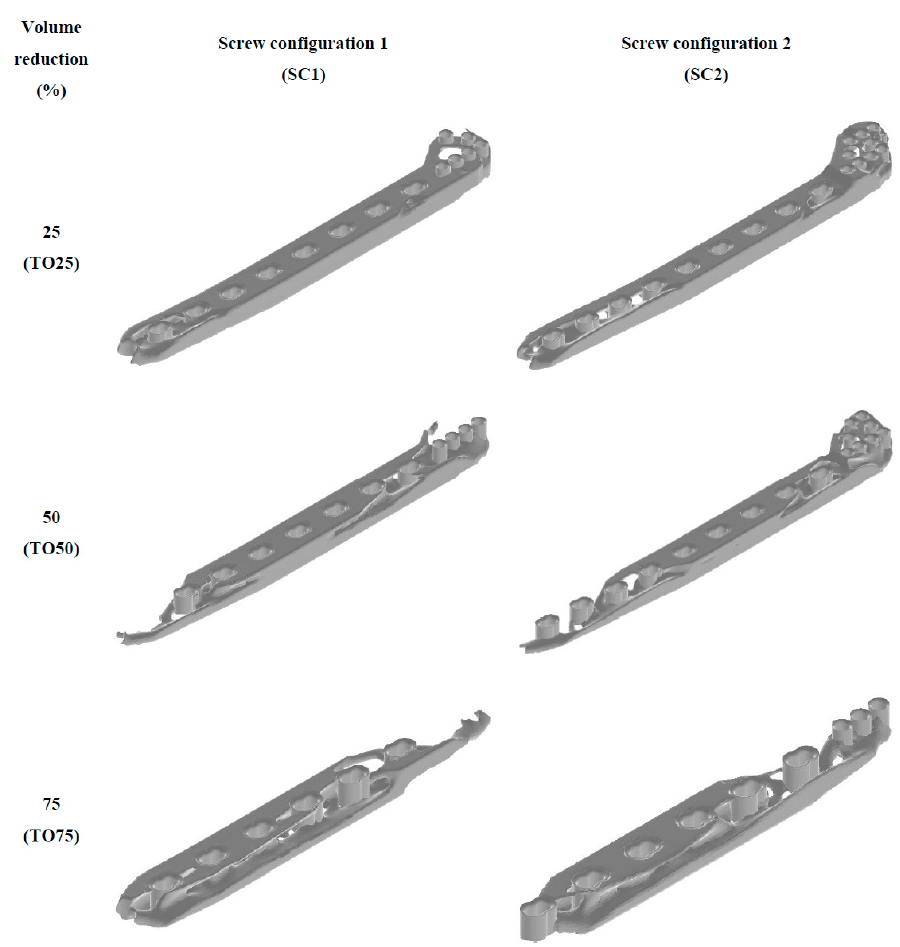
Figure 4. Topology optimization of a custom-fit distal tibia plate under two different screw config- urations.